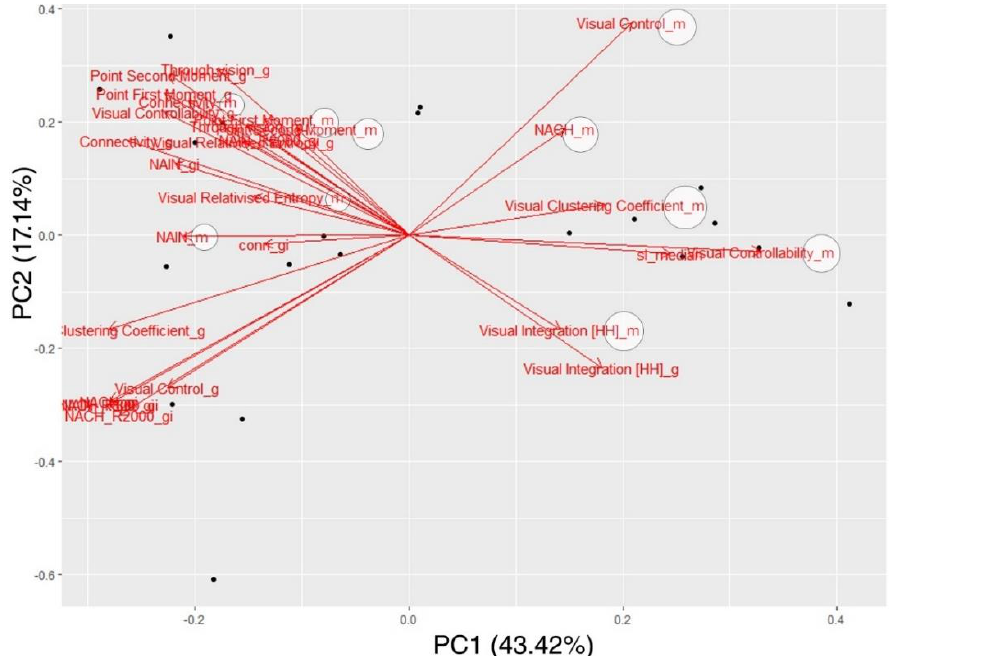
Figure 4 PCA (before K-means analysis), Median (suffix _m) and Gini coefficient